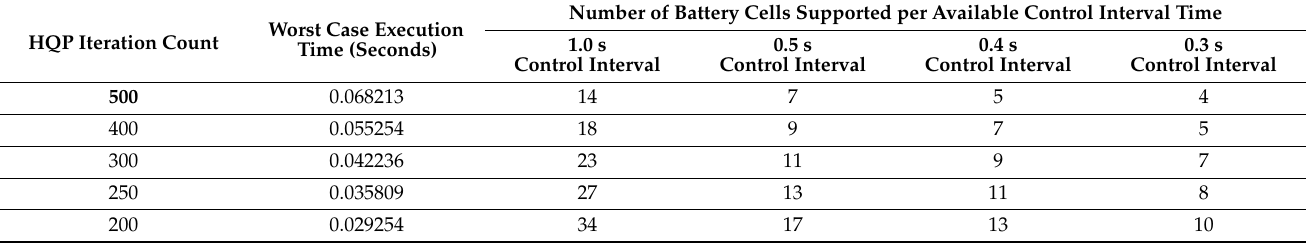
Table 2. Worst-case execution time and number of battery cells supported per sample time. Worst Case Execution HQP Iteration Count Time